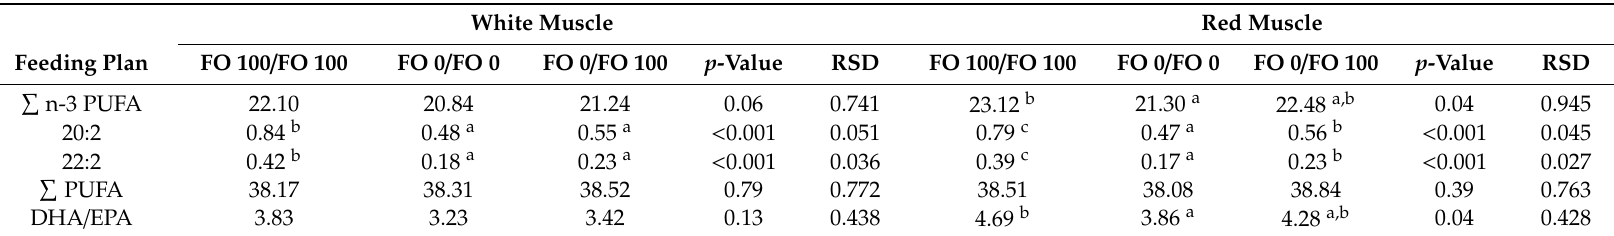
Table 3. Cont. White Muscle Red Muscle